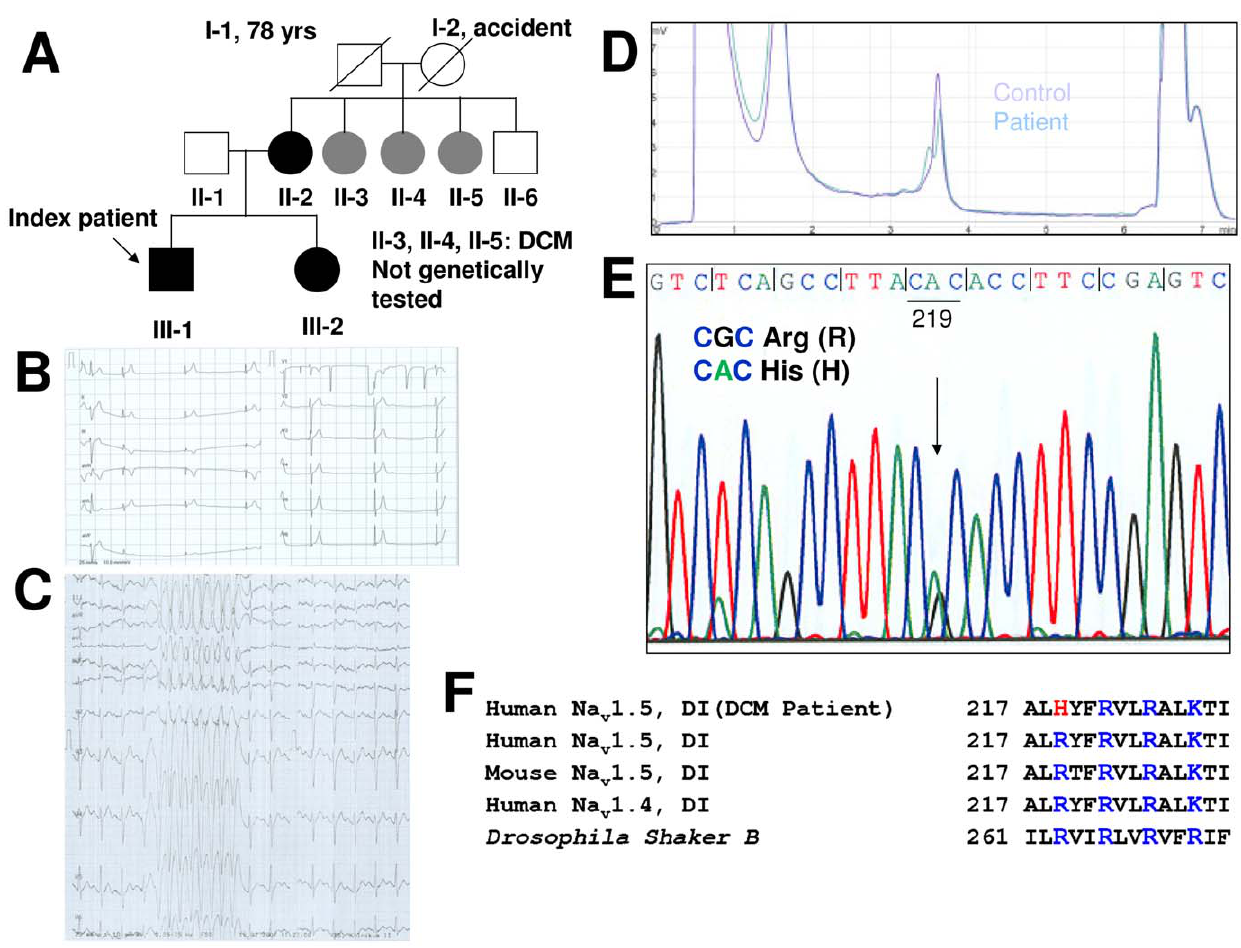
Figure 1. Family pedigree, clinical evaluation, and molecular genetics. ( A ) The index patient (III-1) is indicated by an arrow. Individuals indicated with black squares/circles carry the mutation and a clinical phenotype (III-1, III-2, II-2). Individuals indicated with grey circles (II-3 to II-5) were clinically diagnosed with DCM, but not genotyped. Abbreviation: DCM (dilated cardiomyopathy). ( B ) 12-lead ECG of the index patient showing third degree AV-block with a ventricular escape rhythm and a small QRS-complex with a heart rate of 43 bpm (artefact in lead V1). ( C ) Non-sustained ventricular tachycardia (220 bpm) occurred at a heart rate of 130 bpm and a work load of 192 W during an exercise stress test. ( D ) Different DHPLC eluting profiles at 59.8 u C of the PCR products of exon 6 in the index patient compared to the control. Abbreviation: DHPLC (denaturing high performance liquid chromatography). ( E ) A heterozygous change of arginine CGC (R) to histidine CAC (H) resulted in the missense mutation R219H. ( F ) Sequence alignments of the S4 of domain 1 from Na + and K + ( Shaker B) channels in different